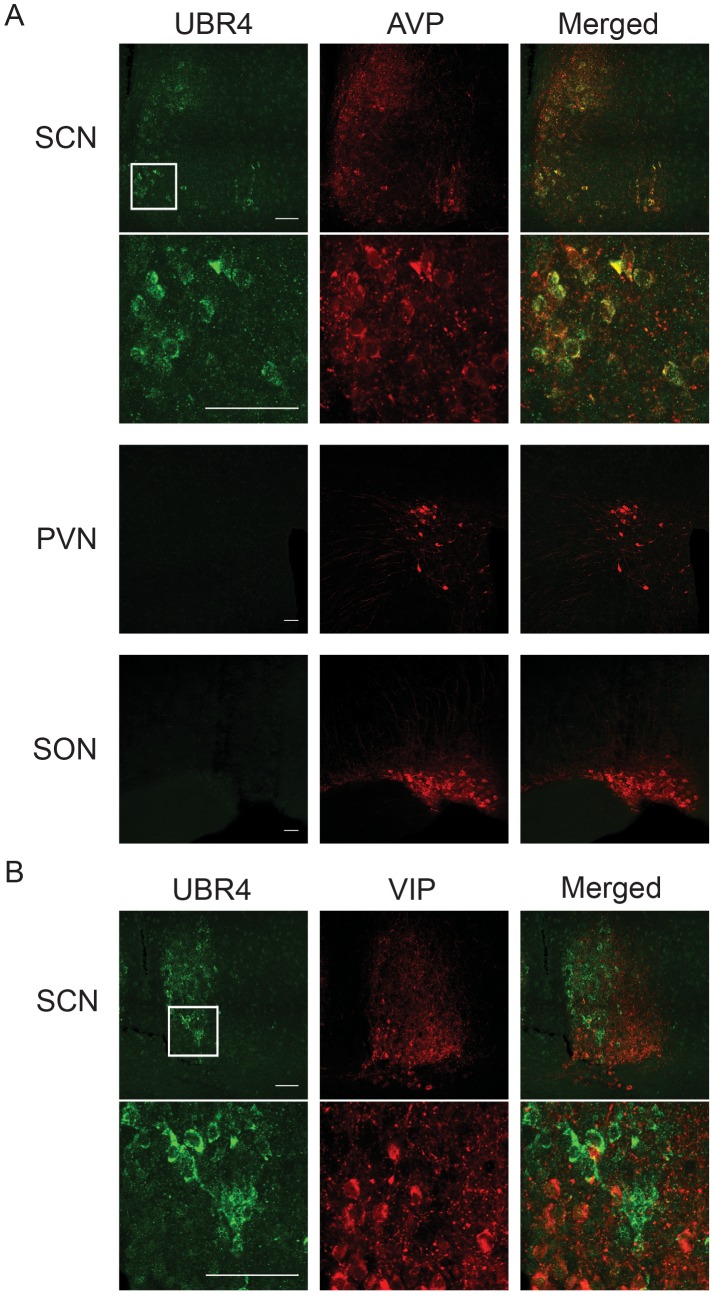
UBR4 is expressed in AVP-positive neurons in the SCN.(A) Expression of UBR4 (left-most column) and AVP (middle column) in the SCN, paraventricular nucleus (PVN) and supraoptic nucleus (SON) were assessed by immunofluorescence staining. The right-most column shows the merged image indicating colocalized expression. UBR4 is expressed in AVP-positive cells of the SCN but was not detected in AVP-positive cells of the PVN or SON. (B) Expression of UBR4 (left-most column) and VIP (middle column) in the SCN. UBR4 is not expressed in VIP-positive cells in the SCN. For (A) and (B), the boxed regions of the SCN are shown in higher magnification in the lower panels. (Scale bar  = 50 µm).